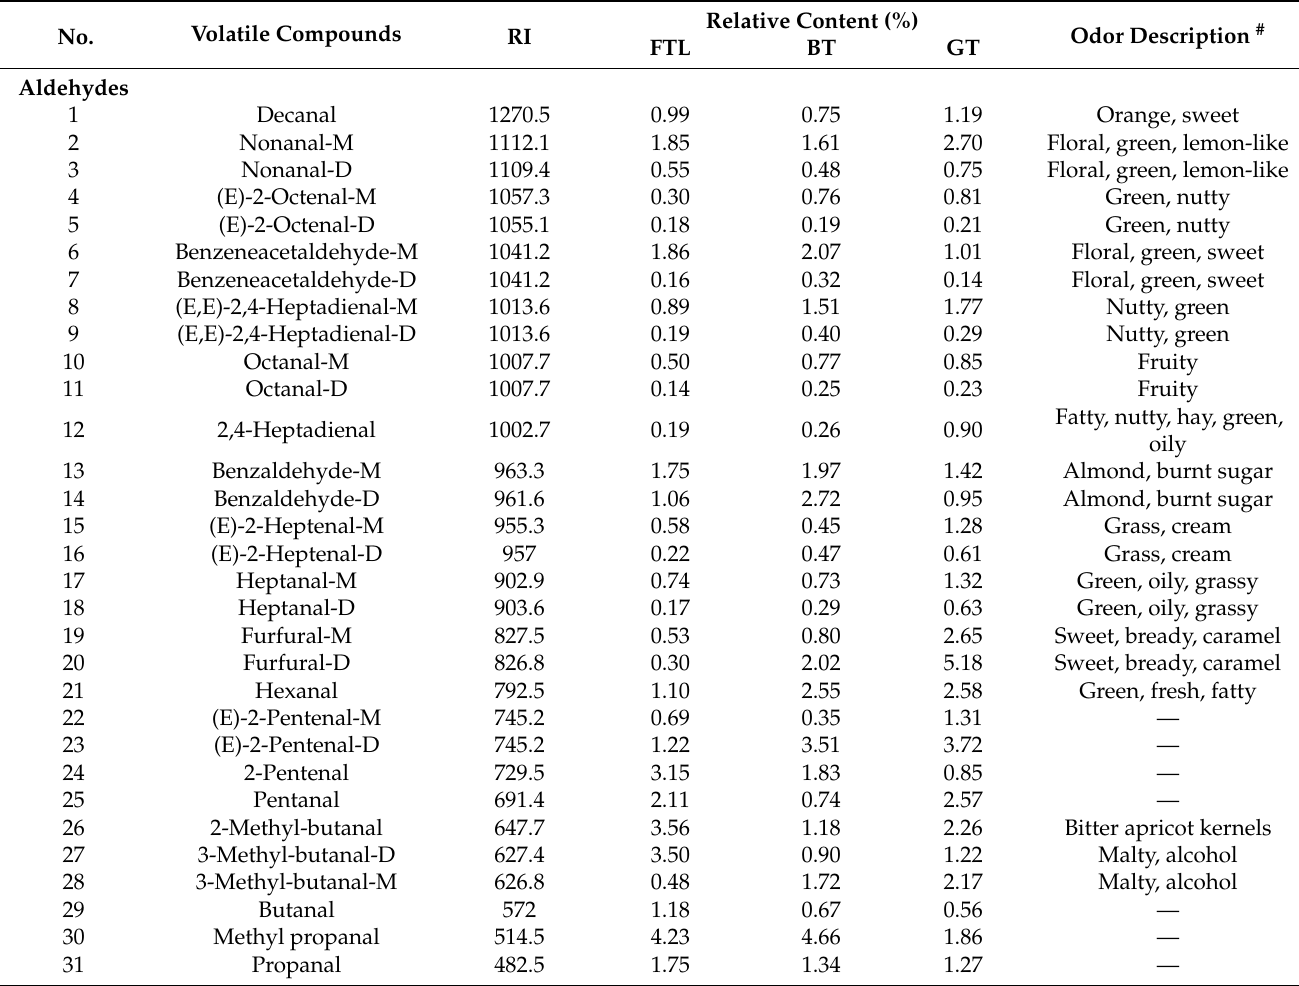
Table 1. Volatile compounds identified in different teas by